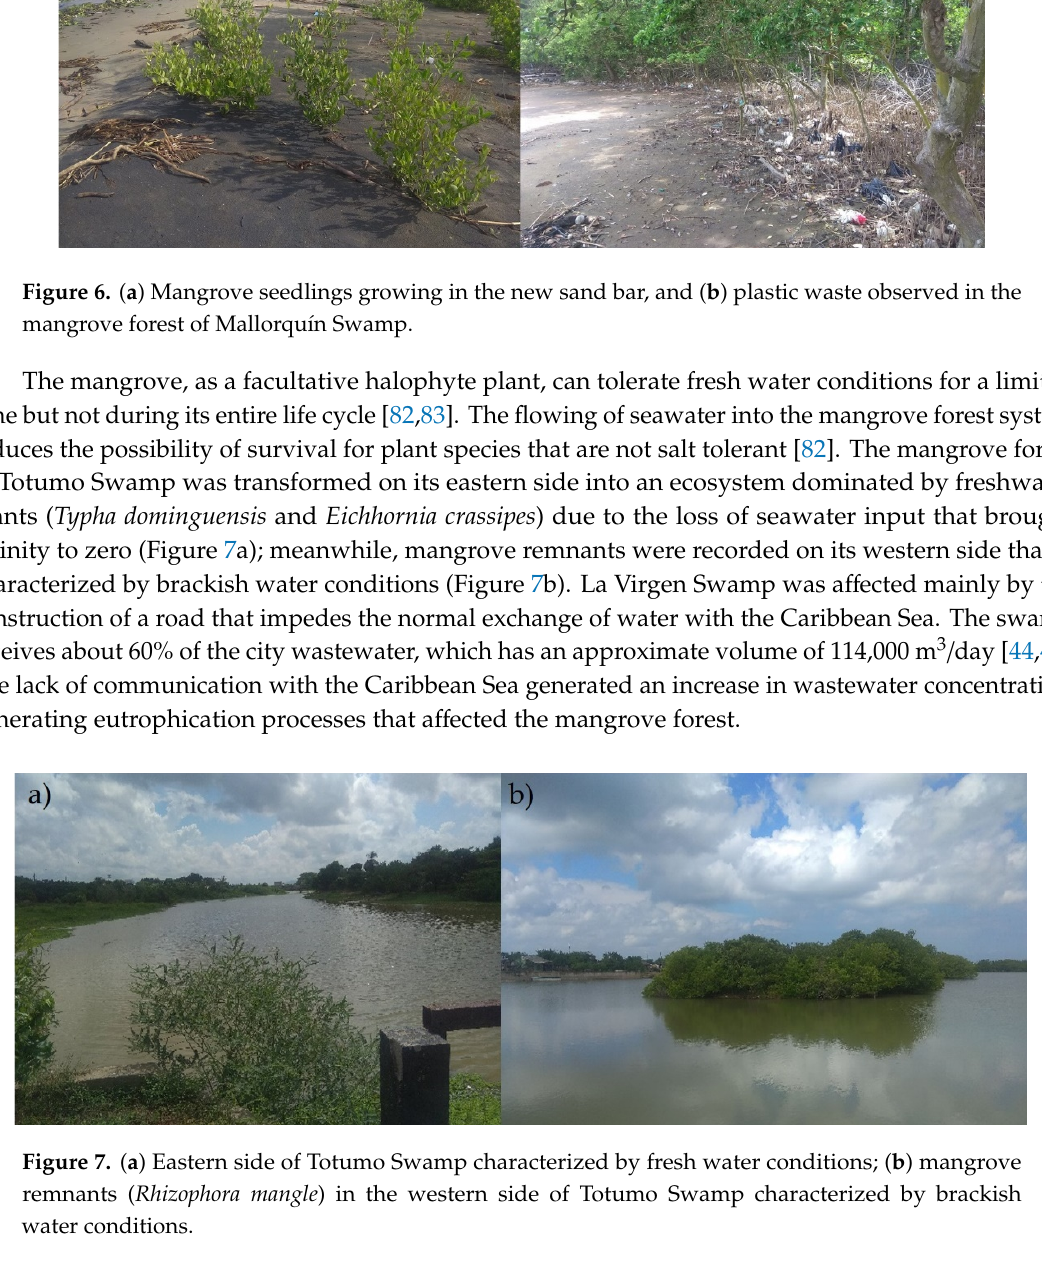
Figure 6. ( a ) Mangrove seedlings growing in the new sand bar, and ( b ) plastic waste observed in the mangrove forest of Mallorquín Swamp.